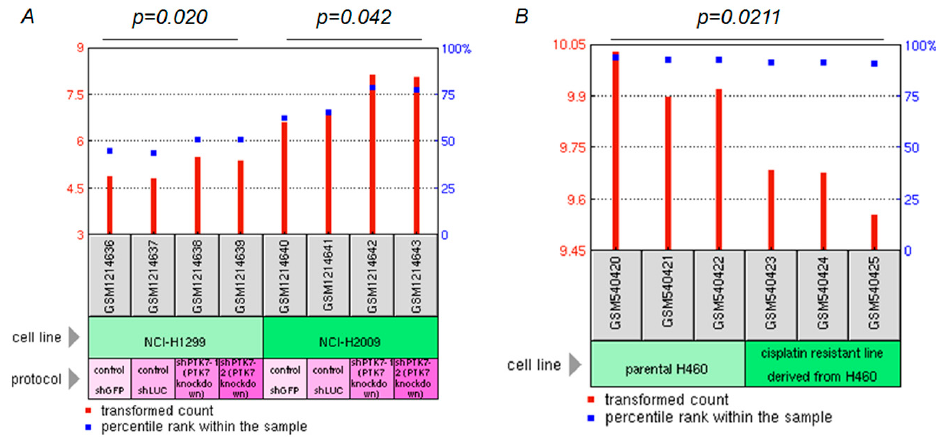
Figure 4. The influence of SNCA on the therapeutic responses of ADC patients. ( A , B ) Two treatment-related microarray datasets (GSE50138 and GSE21656) from the GEO database were used to evaluate the potential functions of SNCA expression on therapeutic effects in ADC patients.